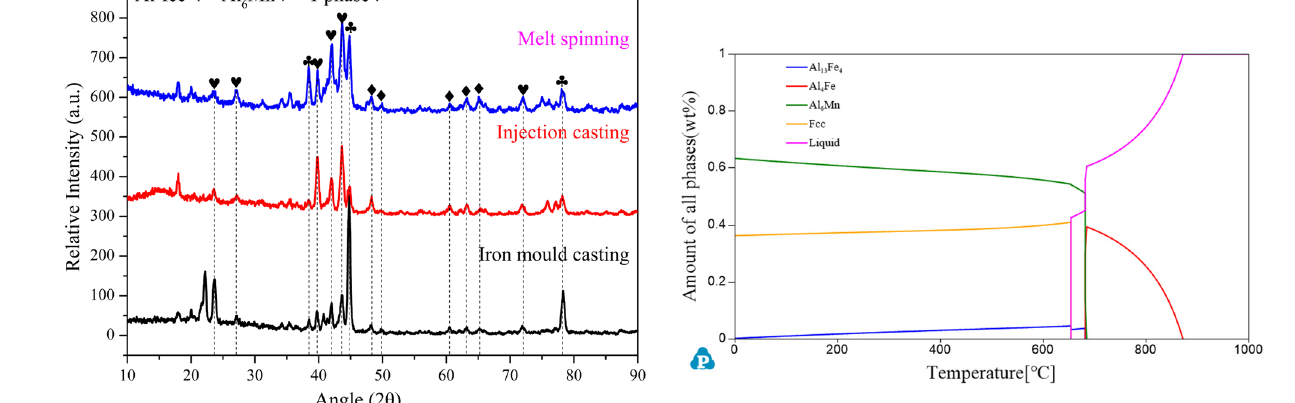
Figure 5: Simulation of Al – Mn – Fe alloy equilibrium crystallization